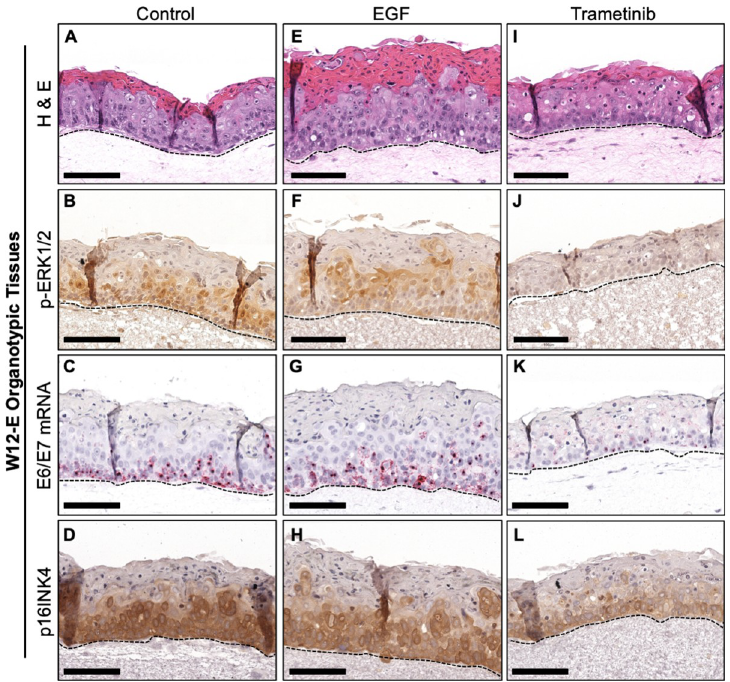
prior to treatment with 10 ng/ml EGF or 10 nM trametinib every second day. FFPE tissues harvested on day 14 were sectioned and stained: (A, E, I) H&E; (B, F, J) IHC for p-ERK1/2; (C, G, K) RNA ISH (red); (D, H, L) IHC for p16. Broken lines underscore the basal cell